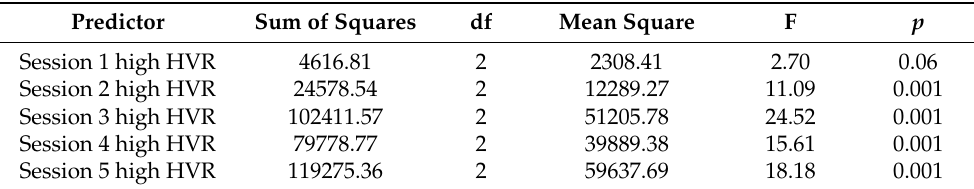
Table 5. Evolution of high HRV values from session to session in all samples.